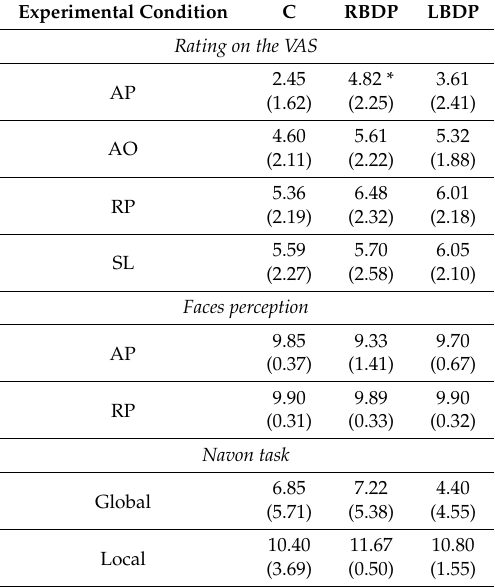
Table 1. Mean and Standard Deviation on experimental tasks. Significant differences are marked with an asterisk (*). Notes. AP = Arcimboldo’s portraits; AO = Arcimboldo’s objects; RP = Renaissance portraits; SL = Still